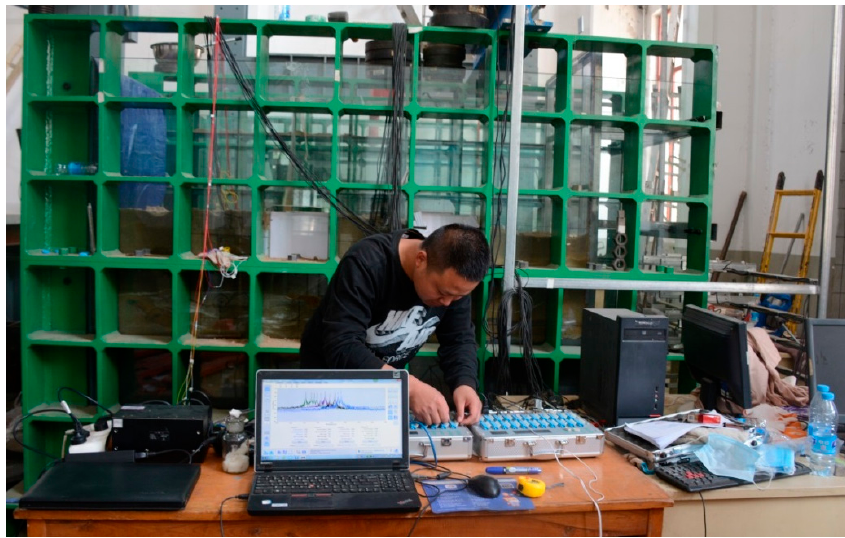
Figure 9. Experiment Scheme of the test model.